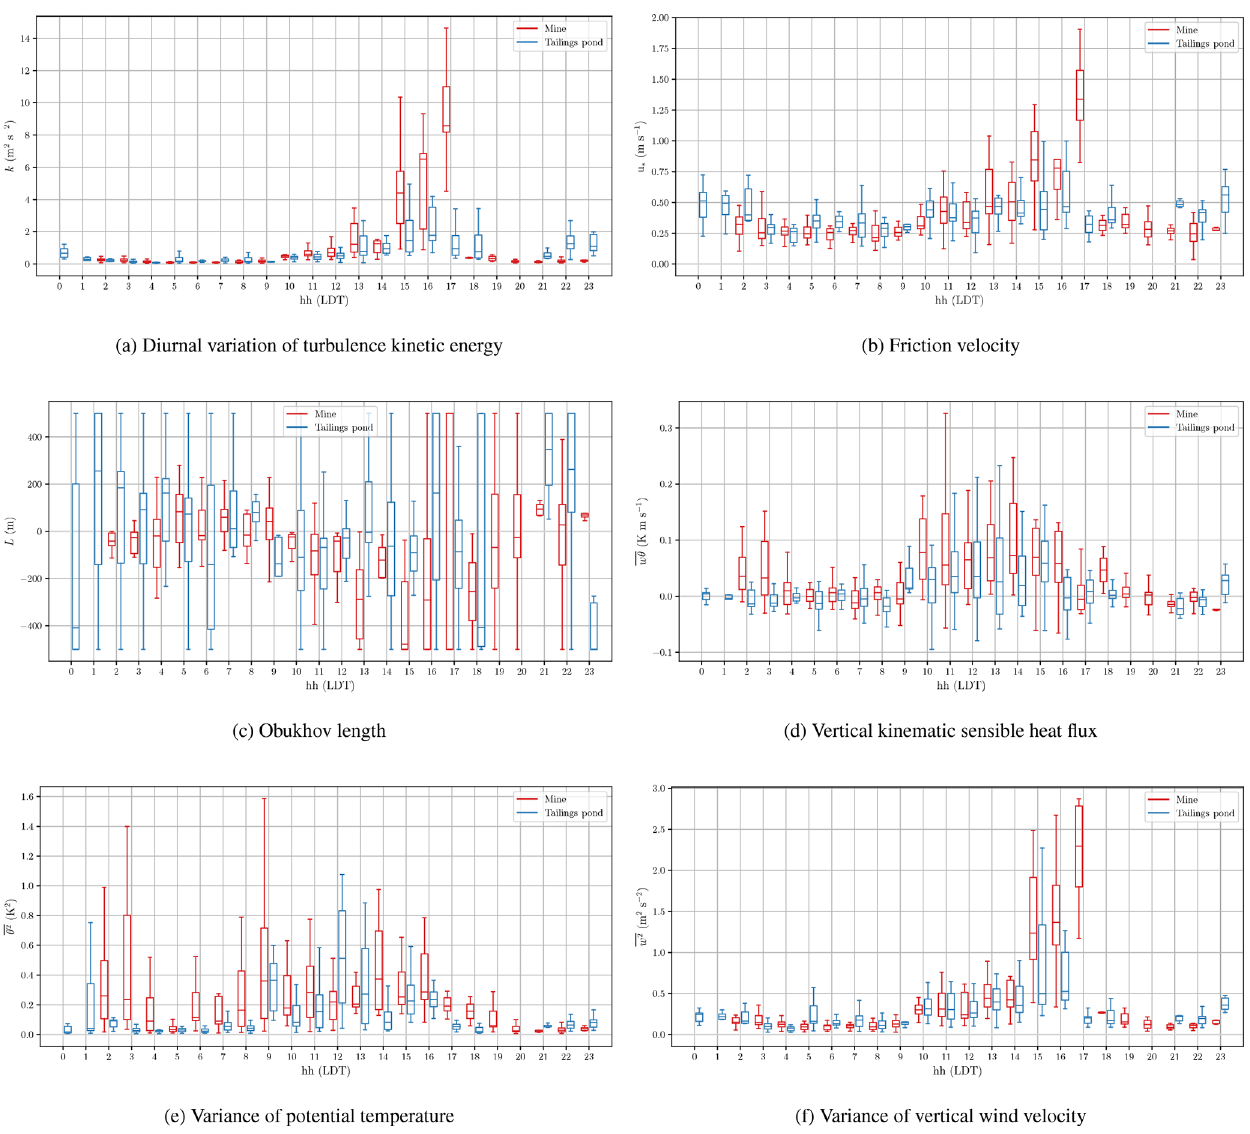
Figure 13. Diurnal variation of different mean and turbulence statistics; at each hour, observations are plotted using statistical percentiles (5th, 25th, 50th, 75th, and 95th); times are in